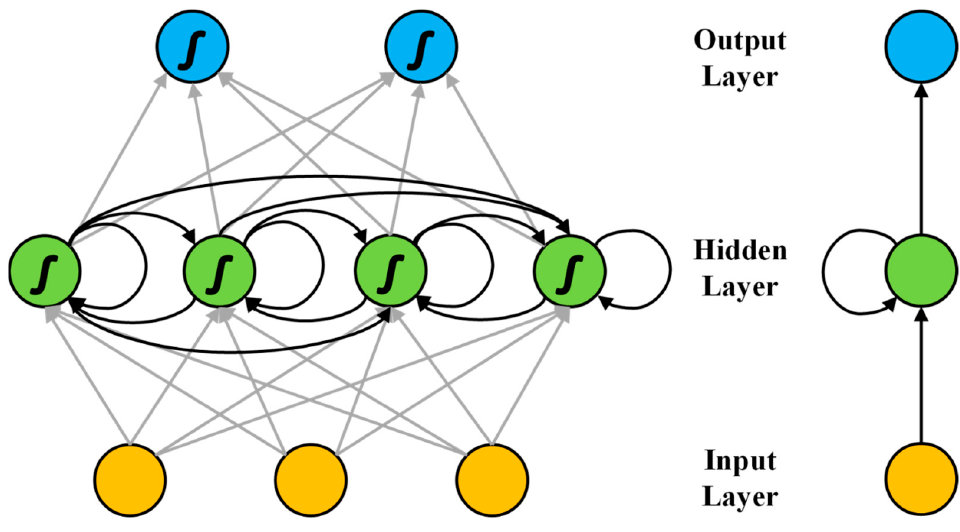
Figure 2. The basic model of simple Recurrent Neural Network.